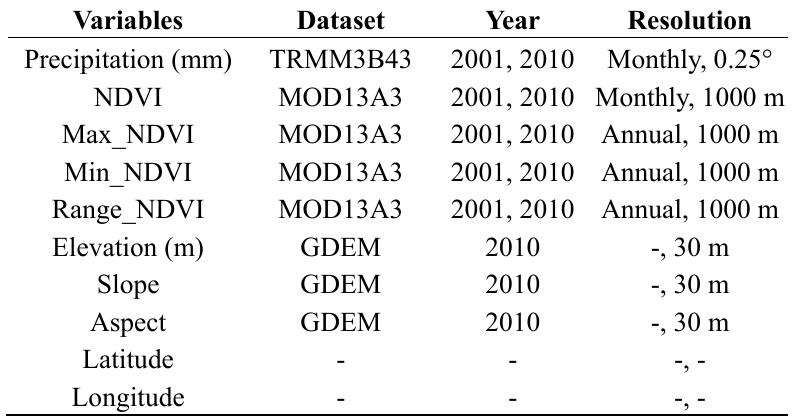
Table 1. Variables used in this study to construct the statistical regression models and to downscale the TRMM 3B43 precipitation